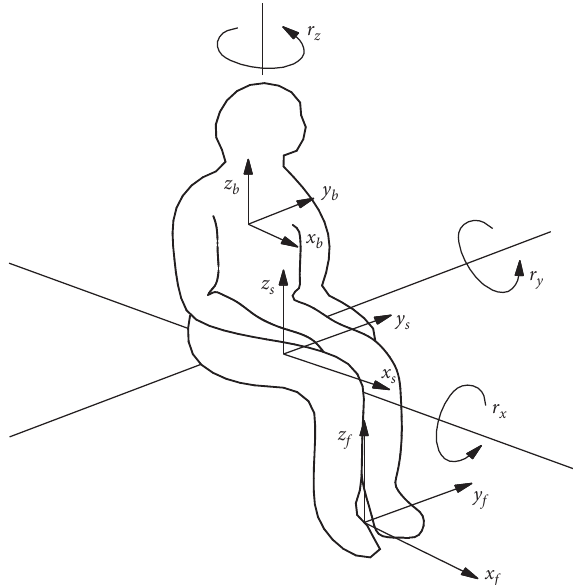
Figure 7: The coordinate system of sitting human